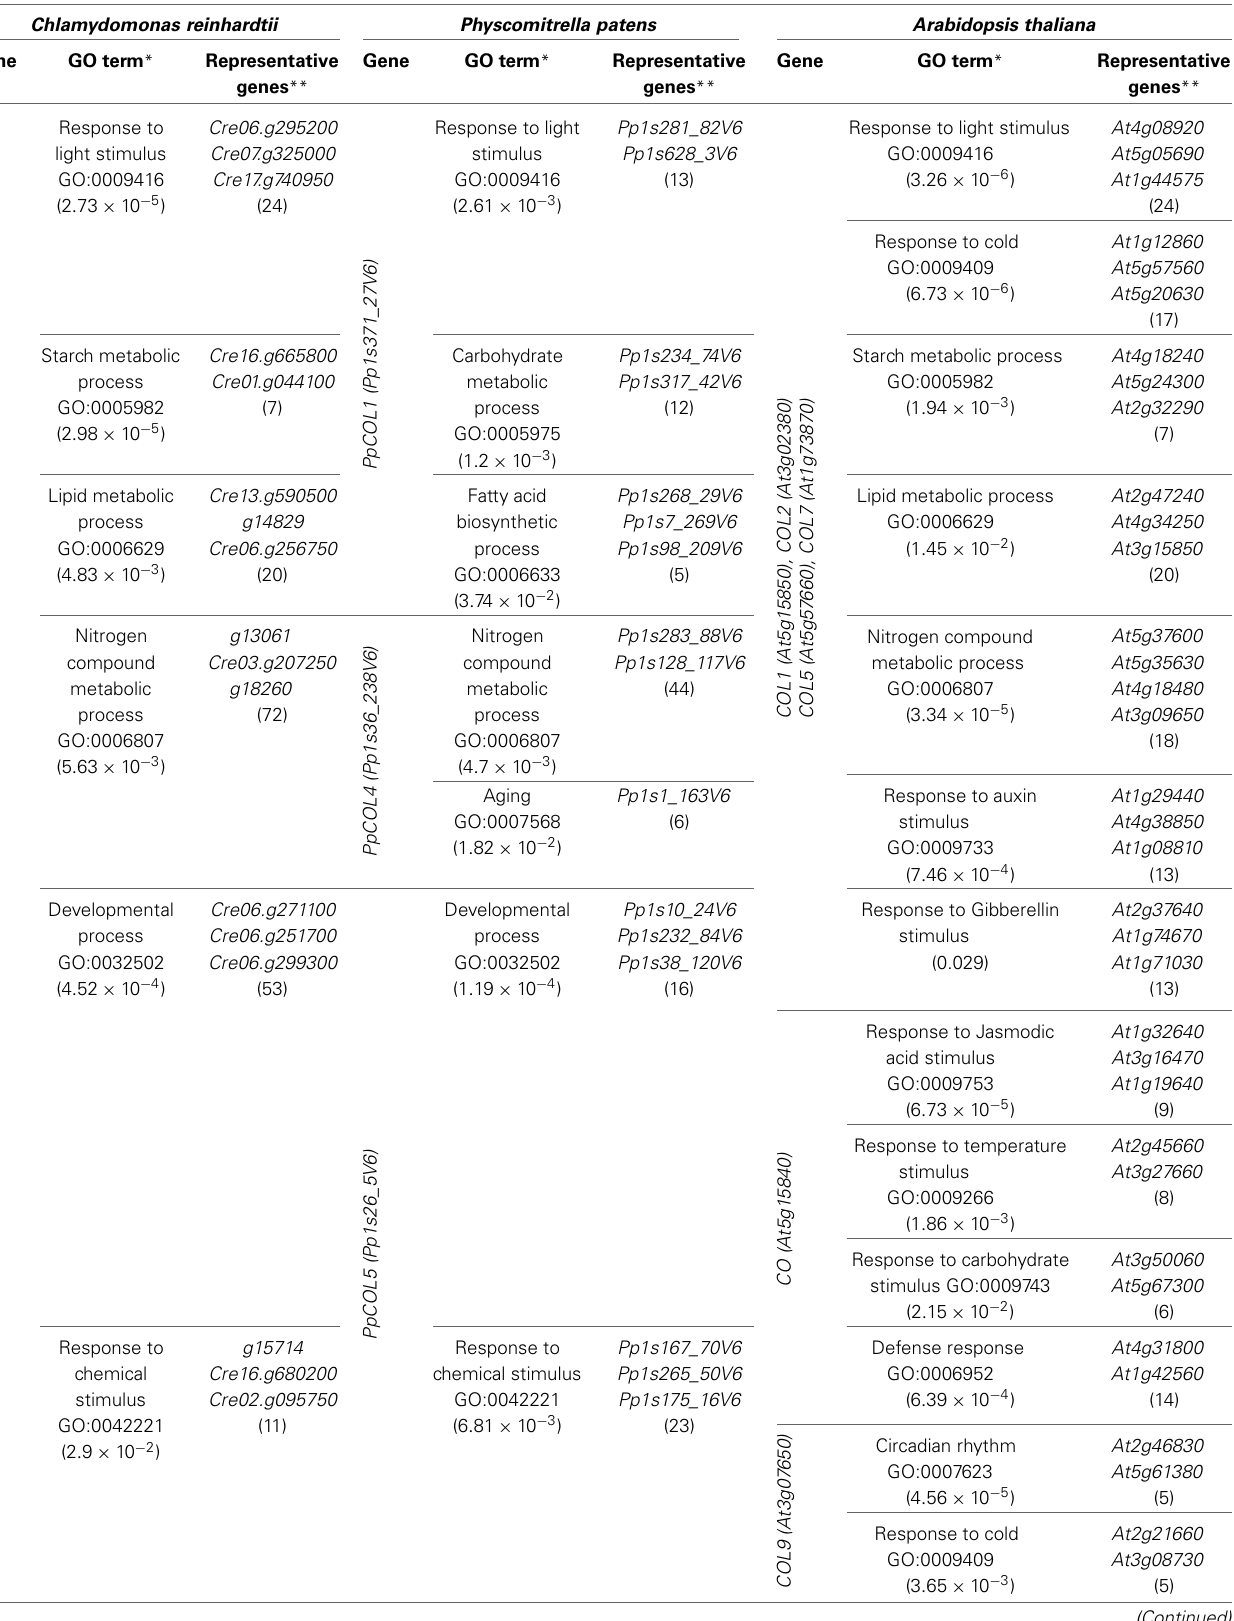
Table 4 | GO terms significantly enriched in CrCO , PpCOLs, and AtCOLs neighborhood in the gene co-expression networks. Chlamydomonas reinhardtii Physcomitrella patens Arabidopsis